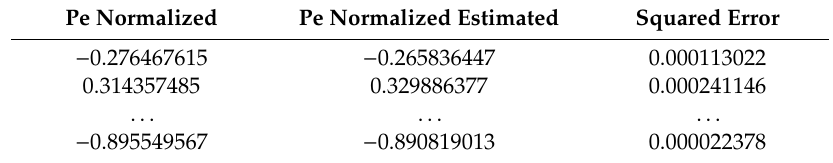
Table 3. “Embedded” ANN performance assessment for the 62 normalized test values of Pe. Pe Normalized Pe Normalized Estimated Squared